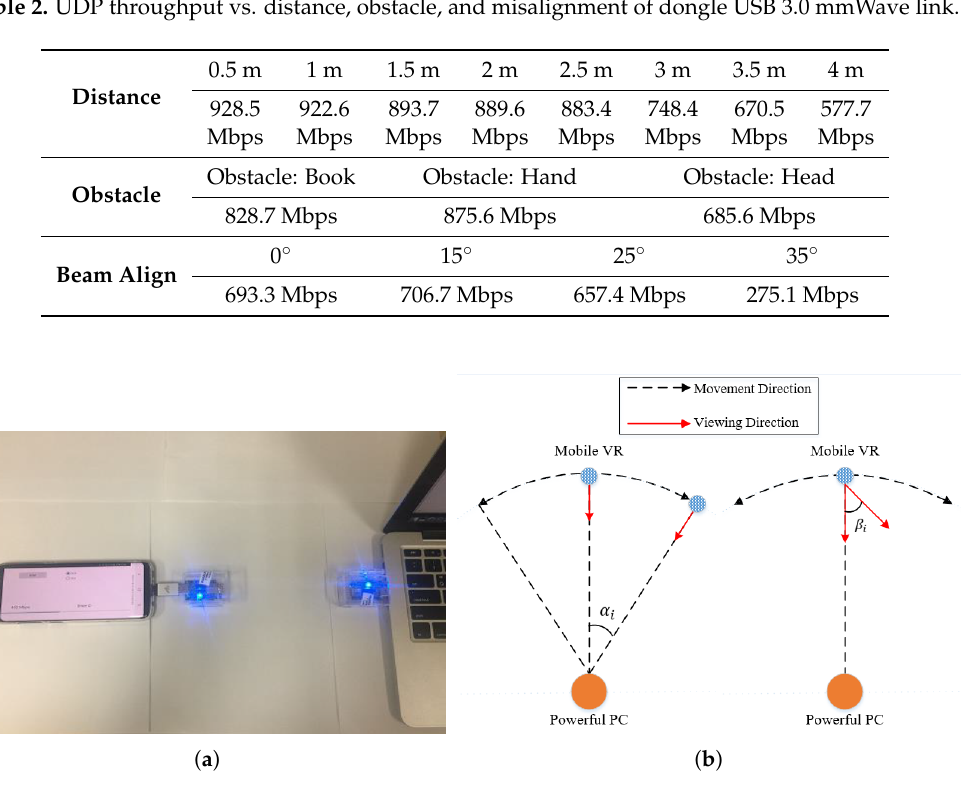
Figure 4. Setting throughput scenario with ( a ) changing the distance, obstacle, ( b )